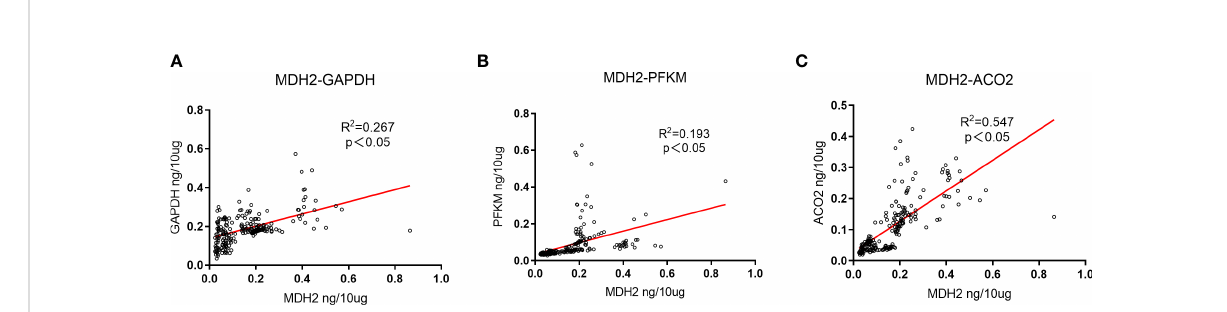
FIGURE 4 Expression correlation analysis of GAPDH, PFKM, ACO2 and MDH2. (A) The correlation between the expression changes of GAPDH in urinary exosomes and MDH2. R2 = 0.267, P<0.05, there is a signi fi cant positive correlation. (B) The correlation between the expression changes of PFKM in urinary exosomes and MDH2. R2 = 0.193, P<0.05, showing a positive correlation. (C) The correlation between the expression changes of ACO2 in urinary exosomes and MDH2. R2 = 0.547, P<0.05, showing a strong positive correlation. The unit is ng/10 m g, which represents the target protein content per 10 m g total protein.